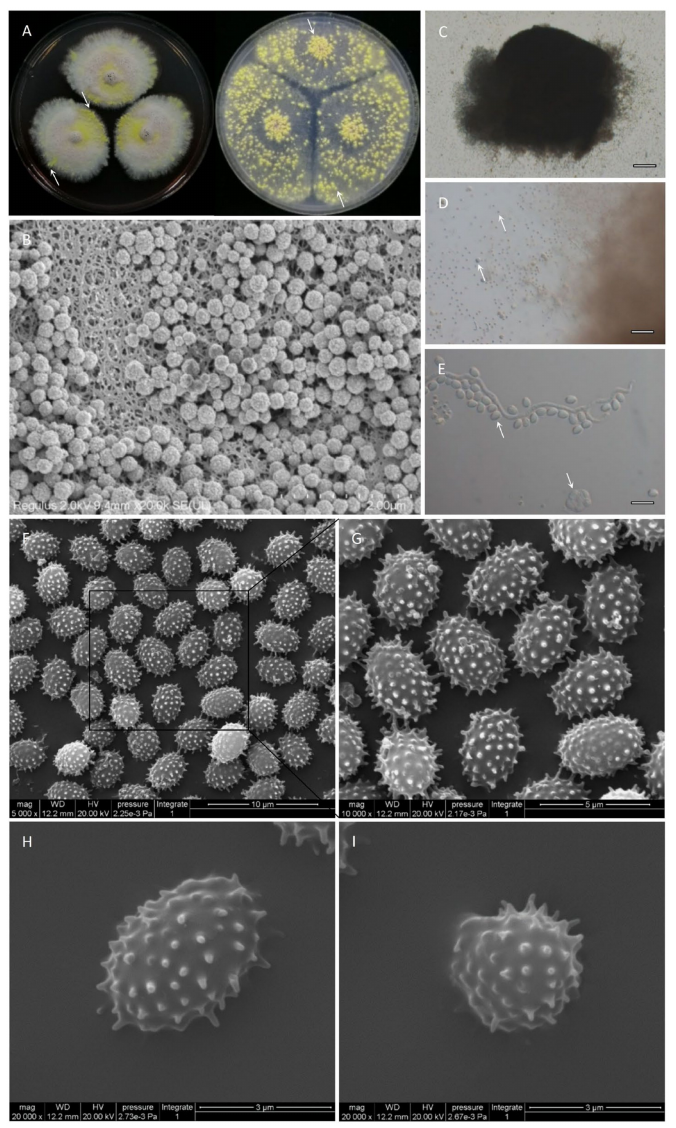
Figure 7. Teleomorphic stage of JP-NJ4 (CCTCC M 2012167). ( A ) Colonies inoculated for 2 wk on CZ (left) and OA (right). ( B – I ) Micromorphological characters of JP-NJ4. ( B ) Primary ascomata collected from OA (inoculation for 1 wk), observed by scanning electron microscope (SEM). ( C – D ) A mature ascoma that is releasing asci and ascospores at different magnification (( C ) 5 × ; ( D ) 20 × ), observed by optical microscope (Zeiss). ( E ) An ascus and ascospores (100 × ). ( F – I ) Ascospores, observed by SEM. Scale bars: B = 2 µ m; C = 200 µ m; D = 50 µ m; E = 10 µ m; F = 10 µ m; G = 5 µ m; H = 3 µ m; I = 3 µ